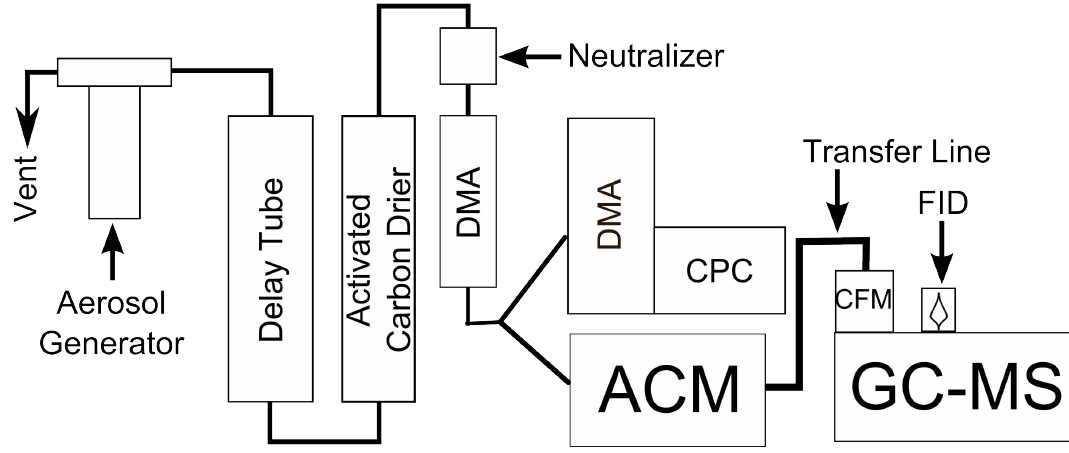
Fig. 3. Schematic of the experimental setup for measuring octadecane aerosols simultaneously with the ACM GC-MS and a SMPS. The aerosols are generated with an aerosol generator, dried, size selected and transferred to the two